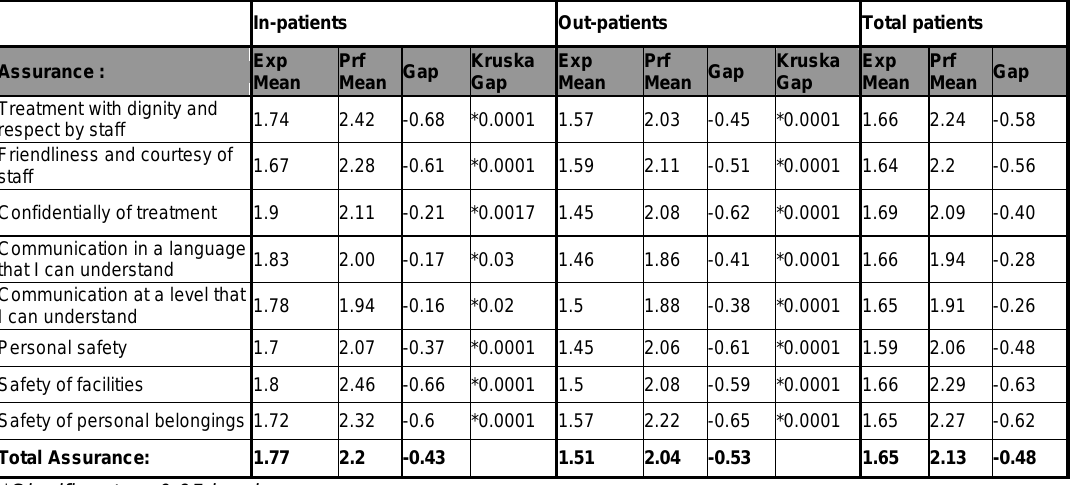
Table 6: Test for significant differences between expectations and perceived performance